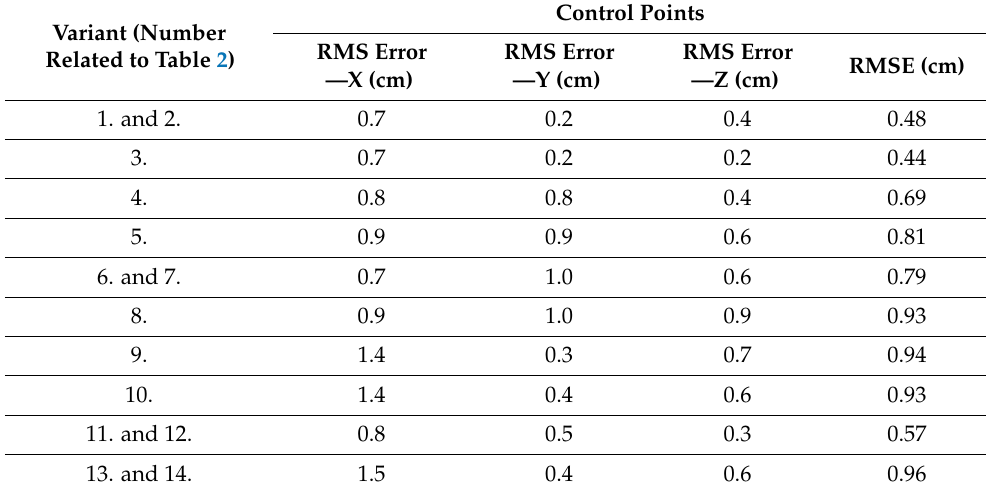
Table 2. Summary of accuracy on control points for variants developed in Pix4D software.